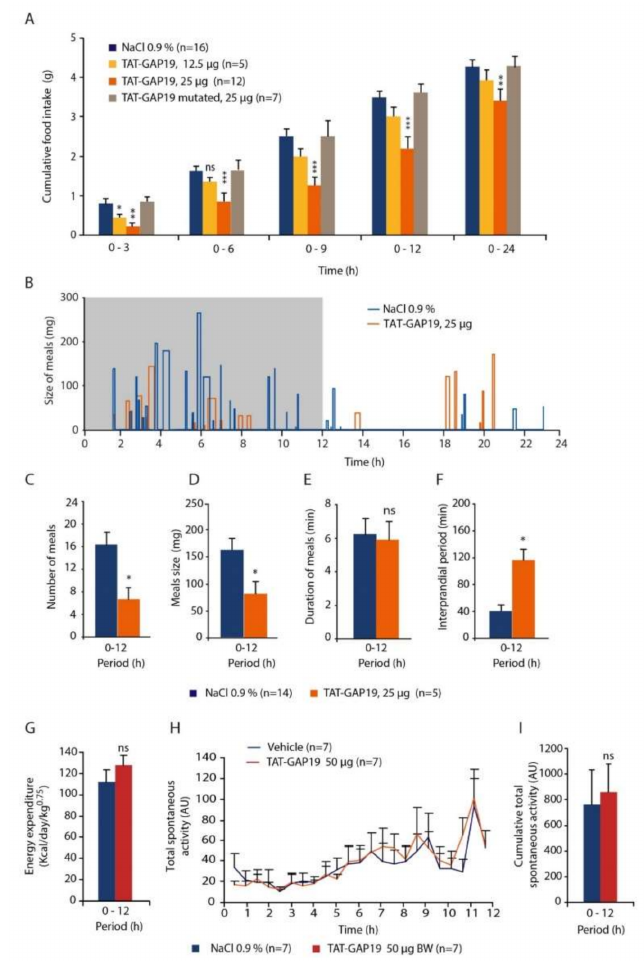
Figure 6. ( A ): Cumulative food intake (g), measured over a 24 h period, of mice having received an i.c.v. injection of either vehicle (Sodium Chloride (NaCl) 0.9%) or TAT-GAP19 (12.5 or 25 µ g). The TAT-GAP19-I14A, which includes a point mutation making it ine ff ective on connexin 43 hemichannels (Cx43 HCs) activity was tested on food intake at the dose of 25 µ g. ( B ): Graph showing meal size over 24 h after i.c.v. injection of vehicle or TAT-GAP19 25 µ g. Note that each bar represents a meal and its width the meal duration. The dark period is represented by the shaded box. ( C – F ): Meal microstructure analysis performed during the dark period for mice that received either vehicle or TAT-GAP19 25 µ g allowed quantification of meals number ( C ), meals size (in mg of food, ( D )), meal duration (in min, ( E )) and interprandial period (in min, average intervals between meals, ( F – G )): Measure of energy expenditure (in Kcal / day-1 / kg 0.75 ) within 12 h after injection of 0.9% NaCl vehicle ( n = 7) or 50 µ g TAT-GAP19 ( n = 7). ( H , I ): Measure of total spontaneous activity (in Arbitrary Unit, UA; ( H ) and cumulative spontaneous activity ( I ) within 12 h for the 2 groups. ns: no significant di ff erence; * p < 0.05, ** p < 0.01 and *** p < 0.001, significantly di ff erent from NaCl-treated